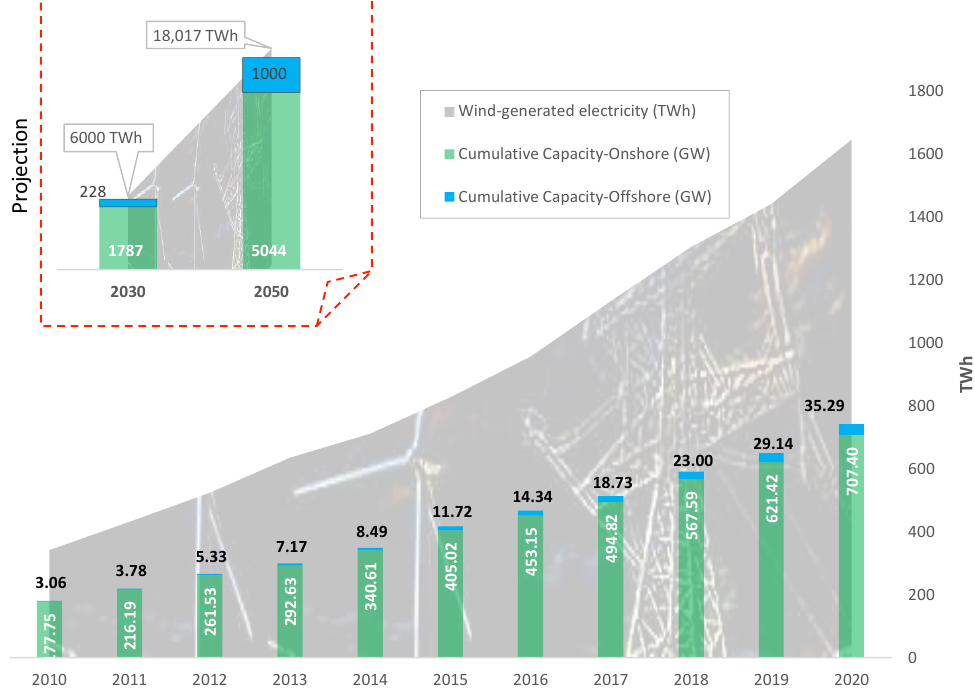
Figure 1. Evolution of electricity generation in the world. Source: [2]—authors’ own elaboration.